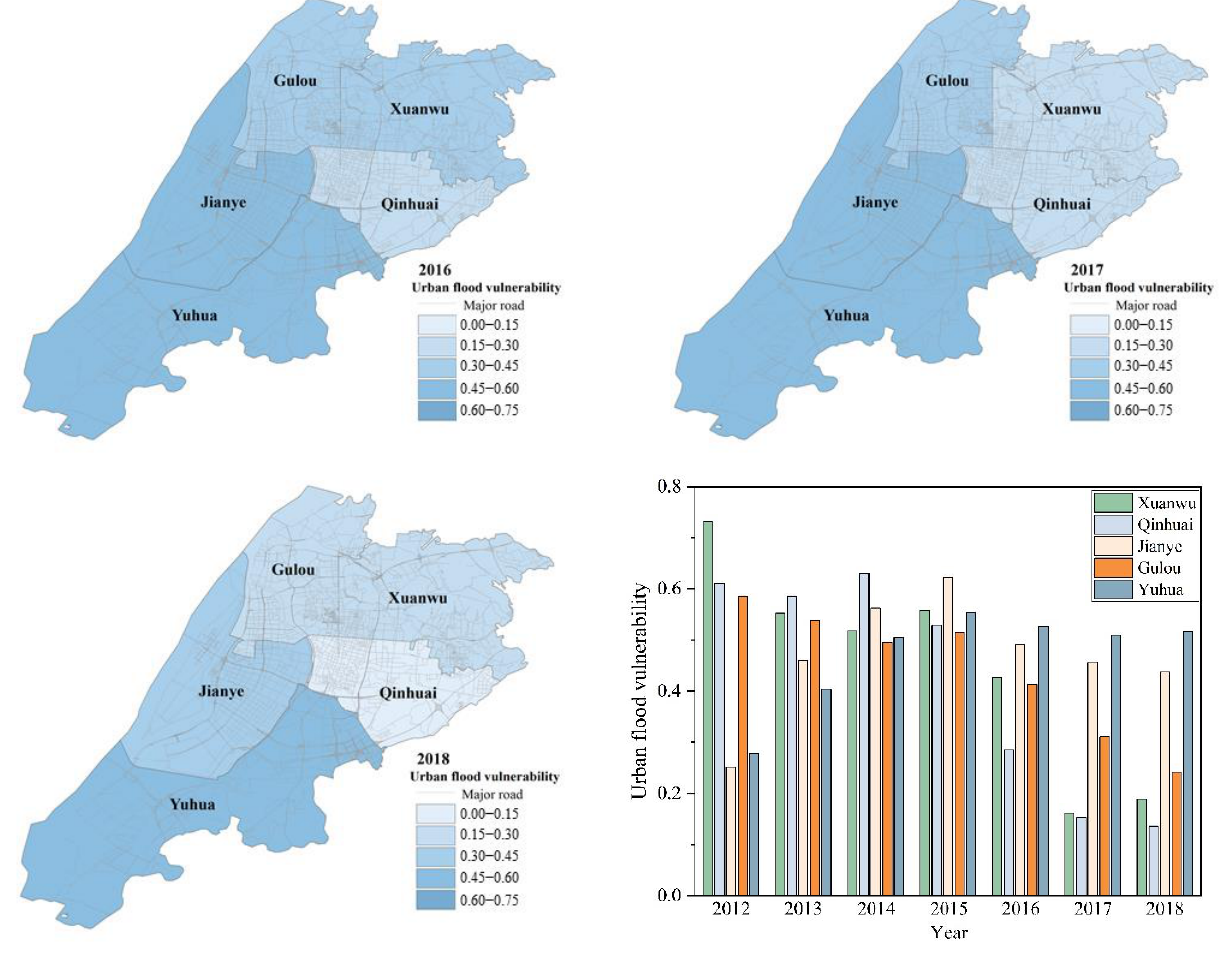
Figure 4. The UFV spatial distribution maps of the XQJGY region.